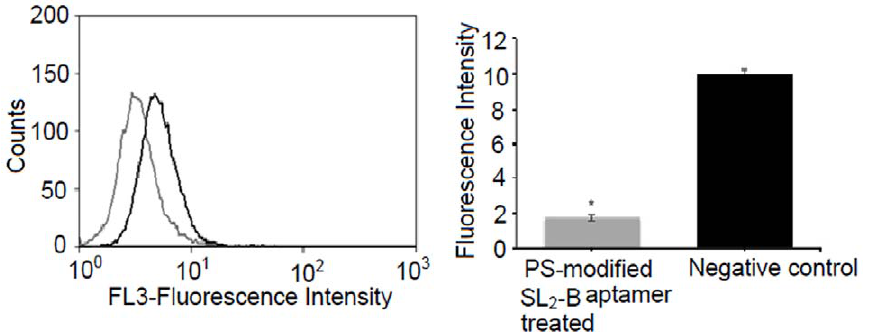
Figure 8. Flow cytometry histogram of Jagged-1 protein expression in Hep G2 cells using anti-human Jagged-1 antibody and quantitative analysis of flow cytometry result. Each histogram curve represents the expression of Jagged-1 obtained with (gray line) and without (black line, negative control) treatment with PS-modified SL 2 -B aptamer at 15 m M concentration. *Significant difference from the negative control sample at p-value , 0.05.